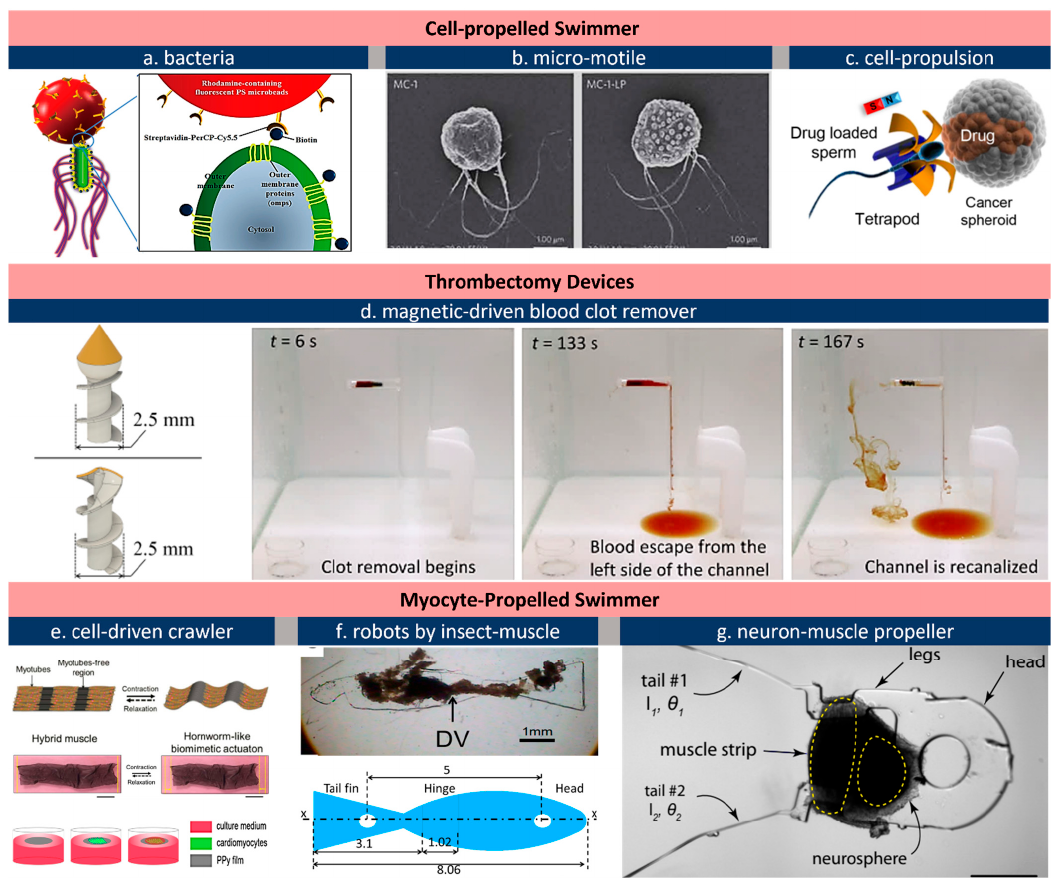
Figure 5. Bio-hybrid actuators for in-body locomotion and general actuation purposes. ( a ), Bacterially propelled micro-swimmer [143]; ( b ), magnetically guided micro-motile for drug delivery to tumor cell [148]; ( c ), sperm-propelled drug delivery vehicle [36]; ( d ), a clot remover driven by external magnets [152]; ( e ), free-swimmer based on skeletal muscles cultured on ultrathin (up) and electrically conducting substrate (bottom) [72,73]; ( f ), a micro biomimetic fish driven by insect muscle [121]; ( g ), cardiomyocyte-propelled swimmer controlled by on-board co-cultured neuron unit [68]. All images are reproduced or adapted with